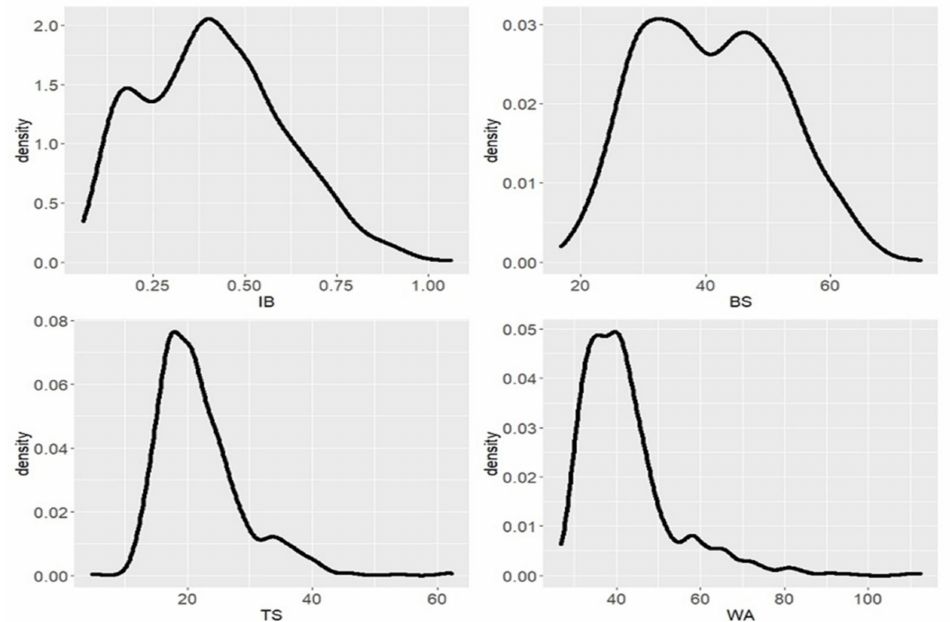
Figure 2. Density distribution of IB, BS, TS and WA